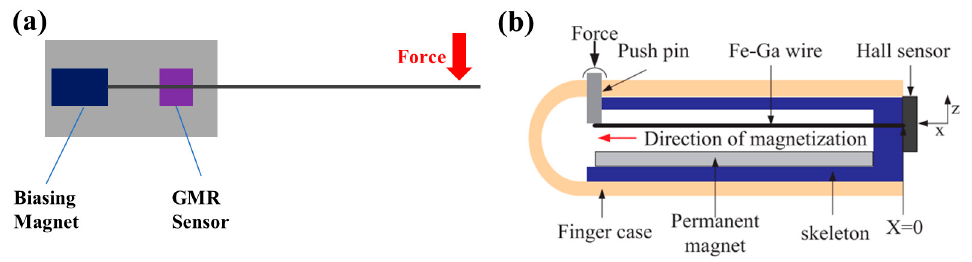
Figure 8. ( a ) Structure diagram of the sensor with a Galfenol beam (designed by Michael Marana); ( b ) Structure diagram of the sensor with three Galfenol beams (designed by Ling Weng). Reprinted with permission from Ref. [49]. Copyright 2020, Elsevier.